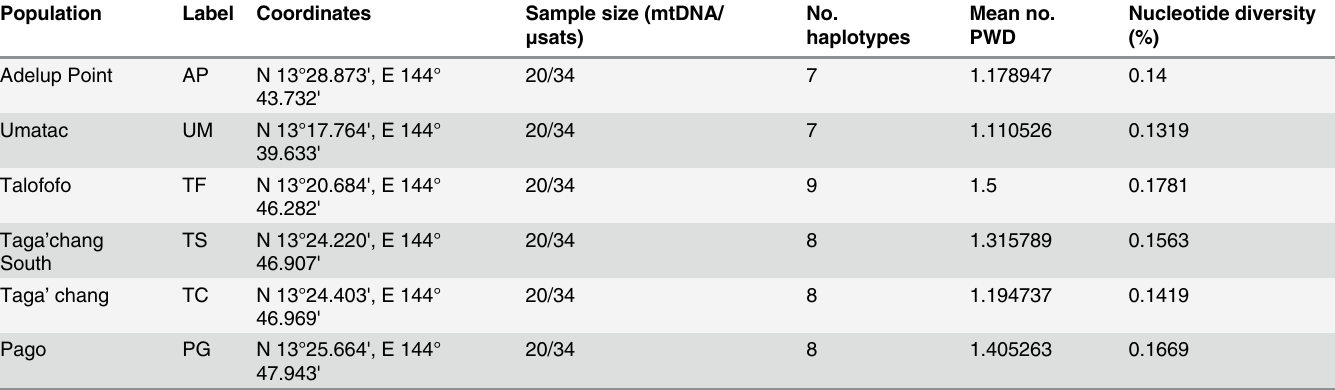
Table 1. Sampling localities, sample sizes and genetic diversity at mtDNA and microsatellite markers (PWD, pair wise differences). Population Label